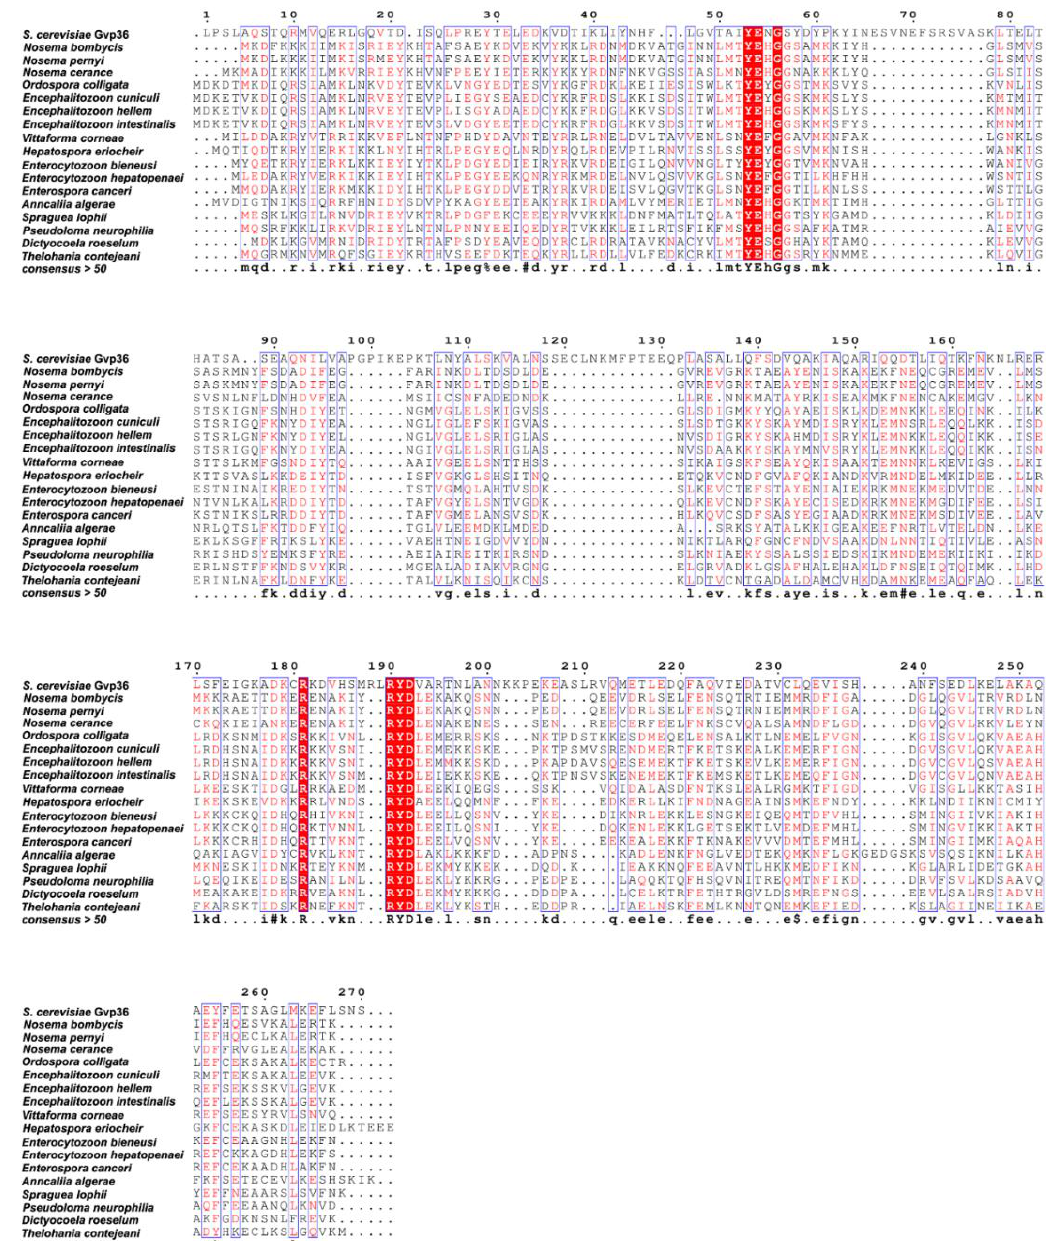
Figure 1. Multiple sequence alignment of microsporidian SWP12 homologs and the BAR-2 domain of Saccharomyces cerevisiae Gvp36. The sequences were aligned with Clustal Omega and rendered by ESPript 3.0. The colored amino acids with blue frames represented the consensus level is greater than 0.7. White characters on a red background highlight the strictly conserved residues. A consensus sequence is generated using criteria from MultAlin. Uppercase is identity, lowercase is consensus level > 0.7, $ is anyone of LM, % is anyone of FY, and # is anyone of NDQEBZ [22] .